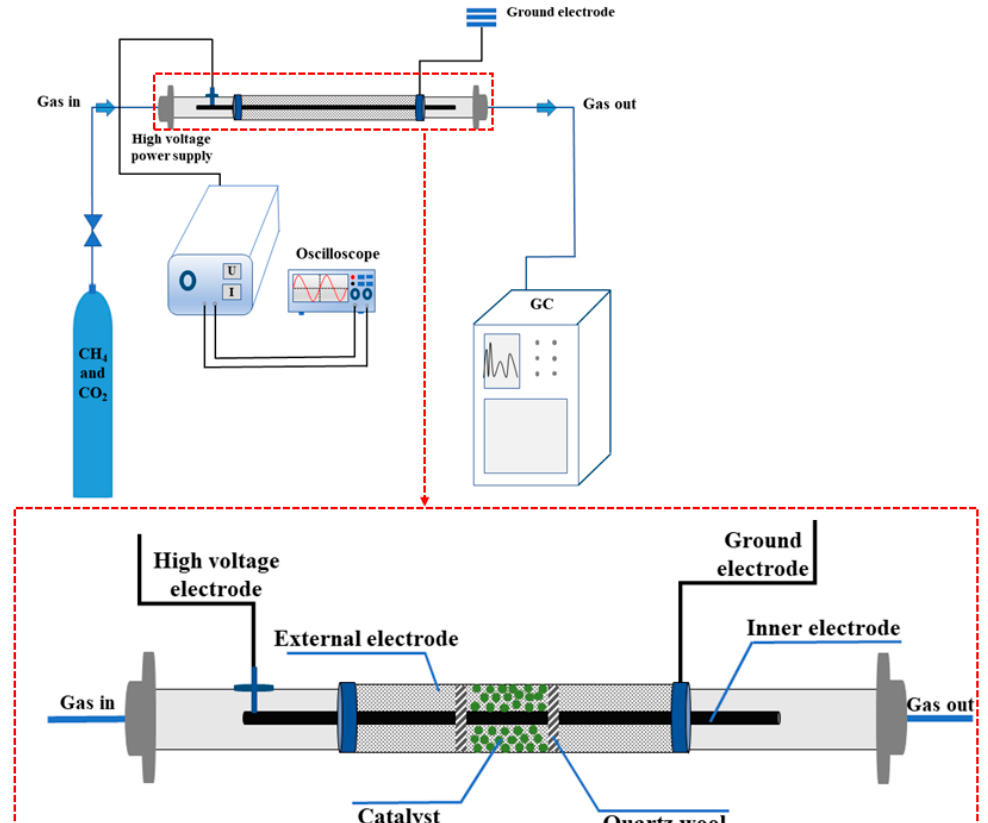
Figure 8. Experimental system diagram. Figure 8.